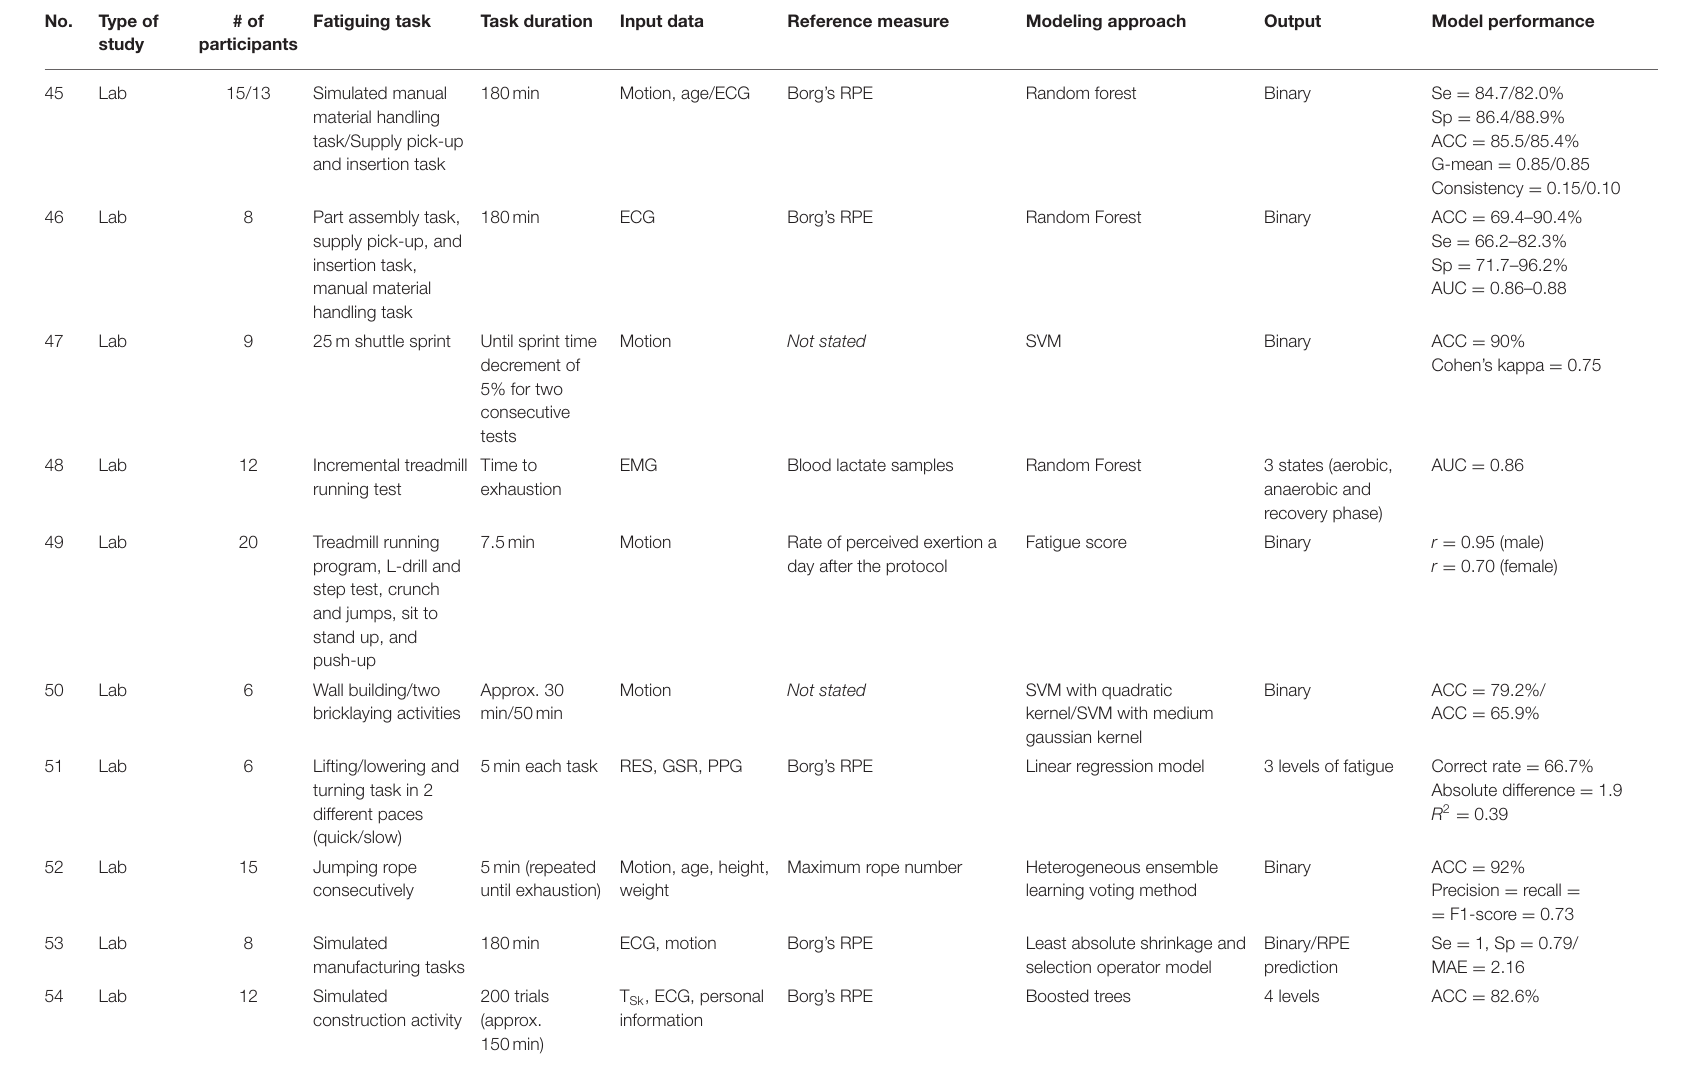
TABLE 6 | Summary of characteristic of studies that investigated physical fatigue quantification using wearable devices.